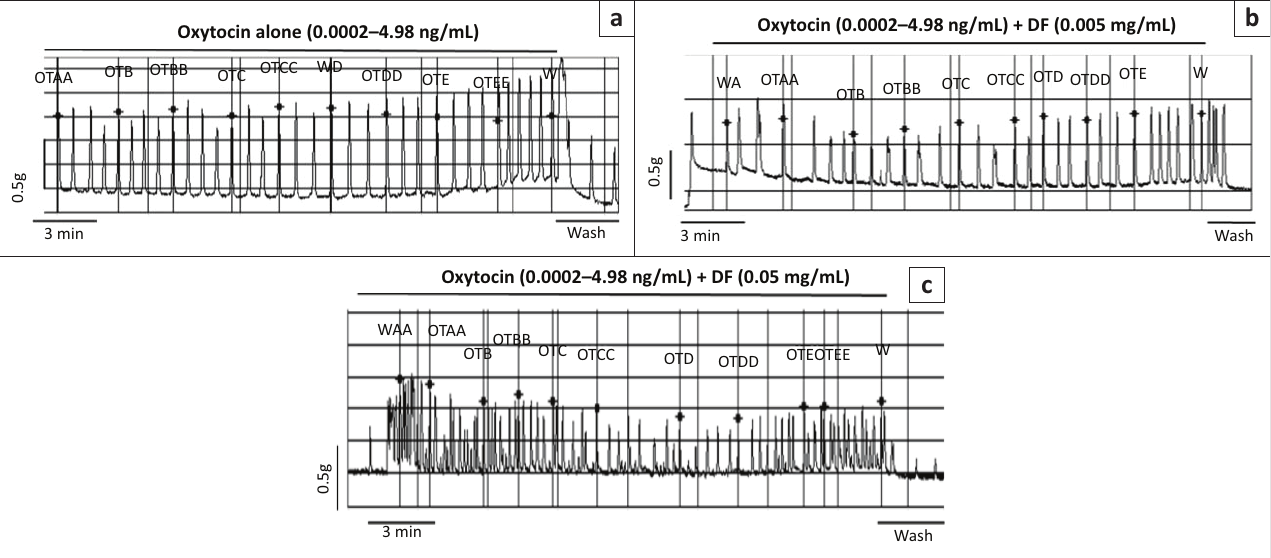
FIGURE 3: Original recordings showing the effect of D. filix-mas (DF) on oxytocin-induced uterine contraction. (a) Original recording oxytocin (0.0002 ng/mL–4.98 ng/mL) on uterine contractility of the isolated mouse uterus. (b) Original recording showing the effect of oxytocin (0.0002 ng/mL–4.98 ng/mL) in the presence of DF (0.005 mg/ mL). (c) Original recording showing the effect of oxytocin (0.0002 ng/mL–4.98 ng/mL) in the presence of DF (0.05 mg/mL).